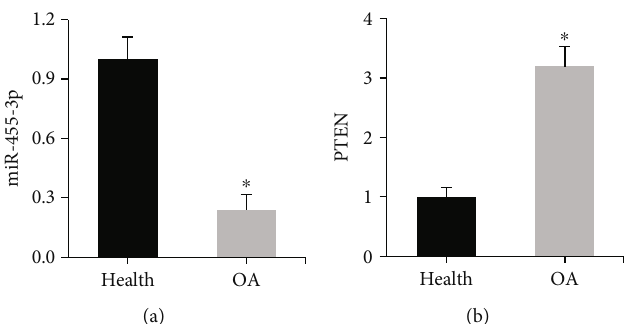
Figure 1: Analysis of gene expression pro fi le in OA and healthy cartilages. Note: OA referred to osteoarthritis. (a) miR-455-3p expression. (b) PTEN expression. ∗ meant P < 0 : 05